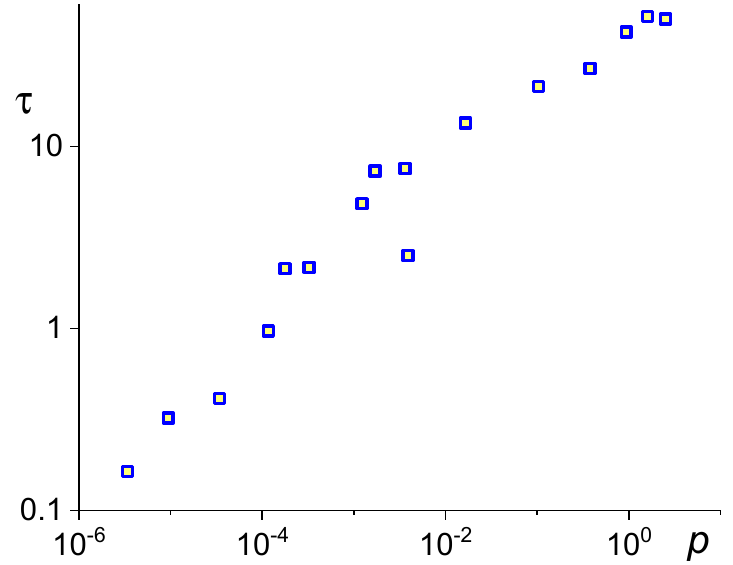
Figure 2. Reduced breakup time τ = t B σ /( R c η m ) determined by Grace [14] for different values of viscosity ratio p .